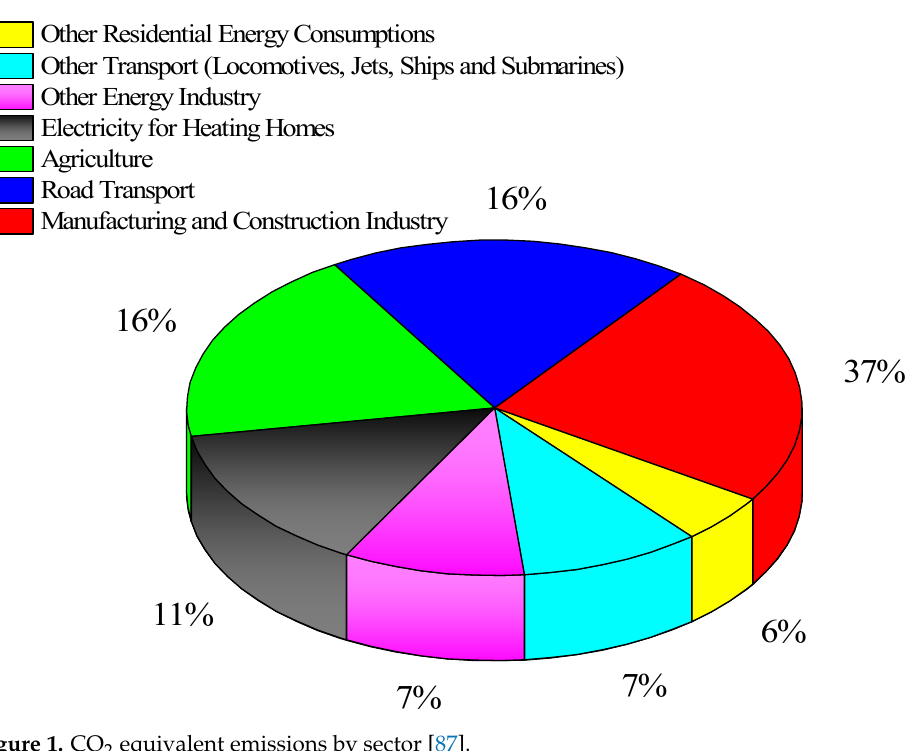
Figure 1. CO 2 equivalent emissions by sector [87].